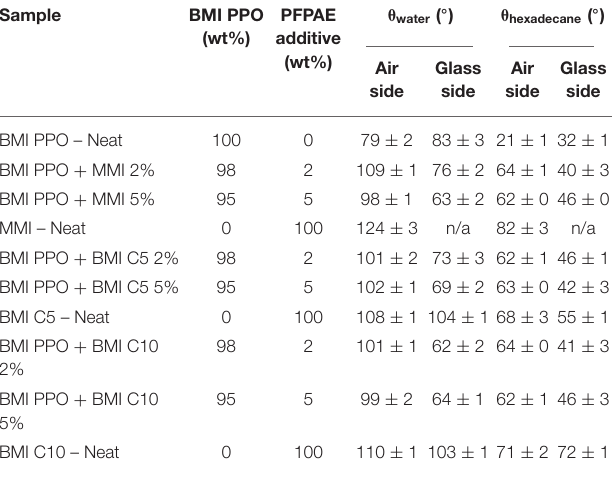
TABLE 3 | Contact angles of the different copolymers of BMI PPO and fluorinated additives. Sample